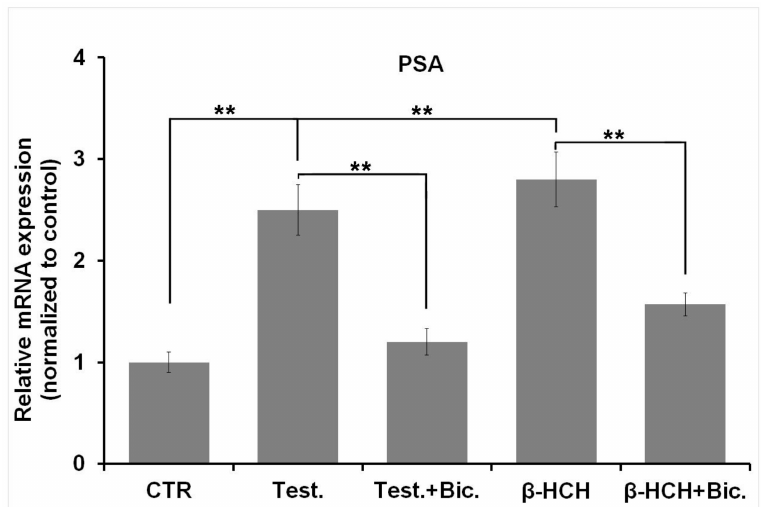
Figure 4. mRNA expression levels for PSA (prostate specific antigen) were analyzed by RT-qPCR. The exposure of LNCaP cells for 4 h to 10 µ M β -HCH or 30 nM testosterone results in a two-fold PSA overexpression compared to the control untreated cells. Overnight pretreatment with 120 nM bicalutamide largely prevents the increase in PSA mRNA level. PSA expression values were